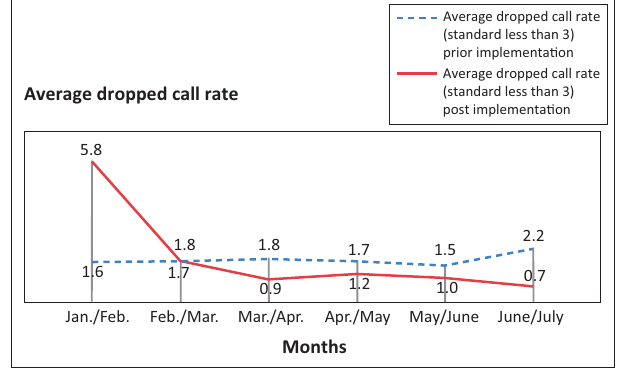
Average dropped call rate